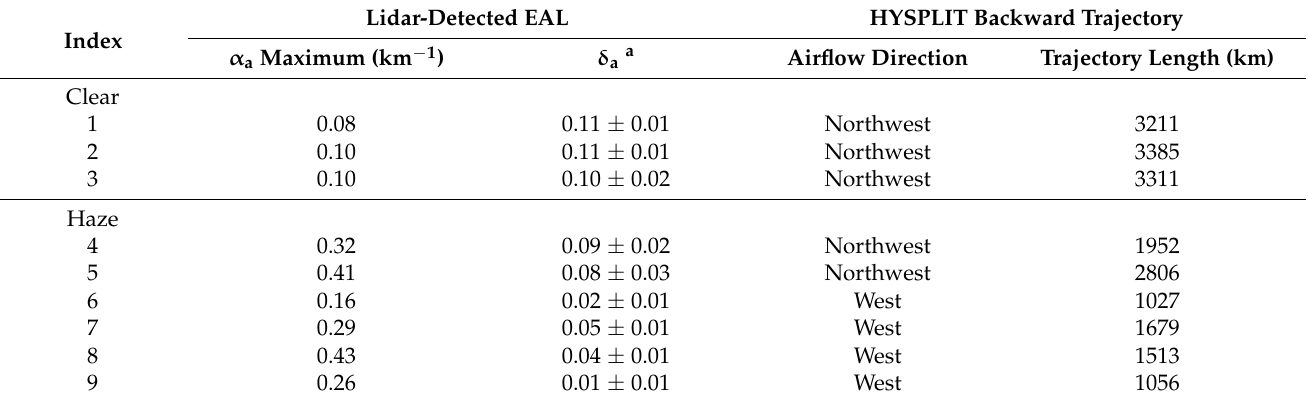
a average δ a at the layer altitudes during the evolution of each